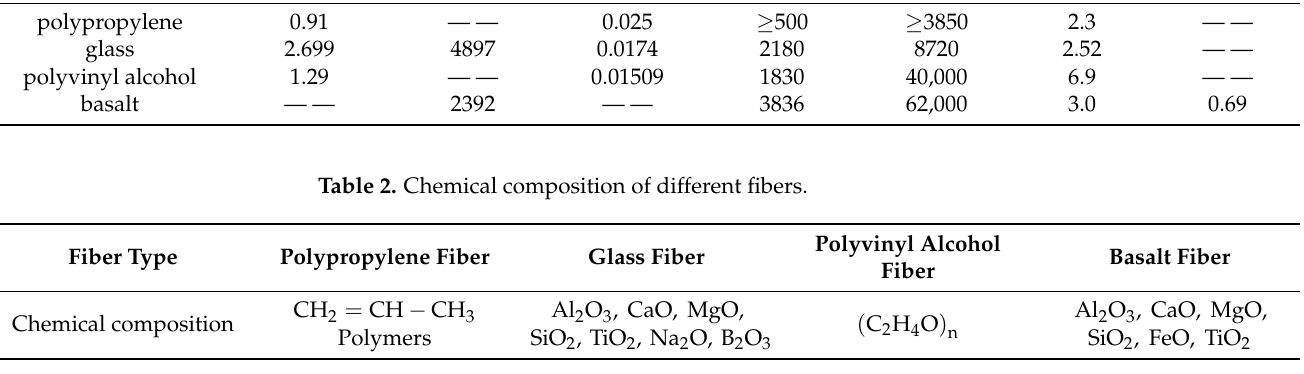
Figure 2. Physical and SEM micrographs of four fibers: ( a ) polypropylene fiber; ( b ) glass fiber; ( c ) polyvinyl alcohol fiber; ( d ) basalt